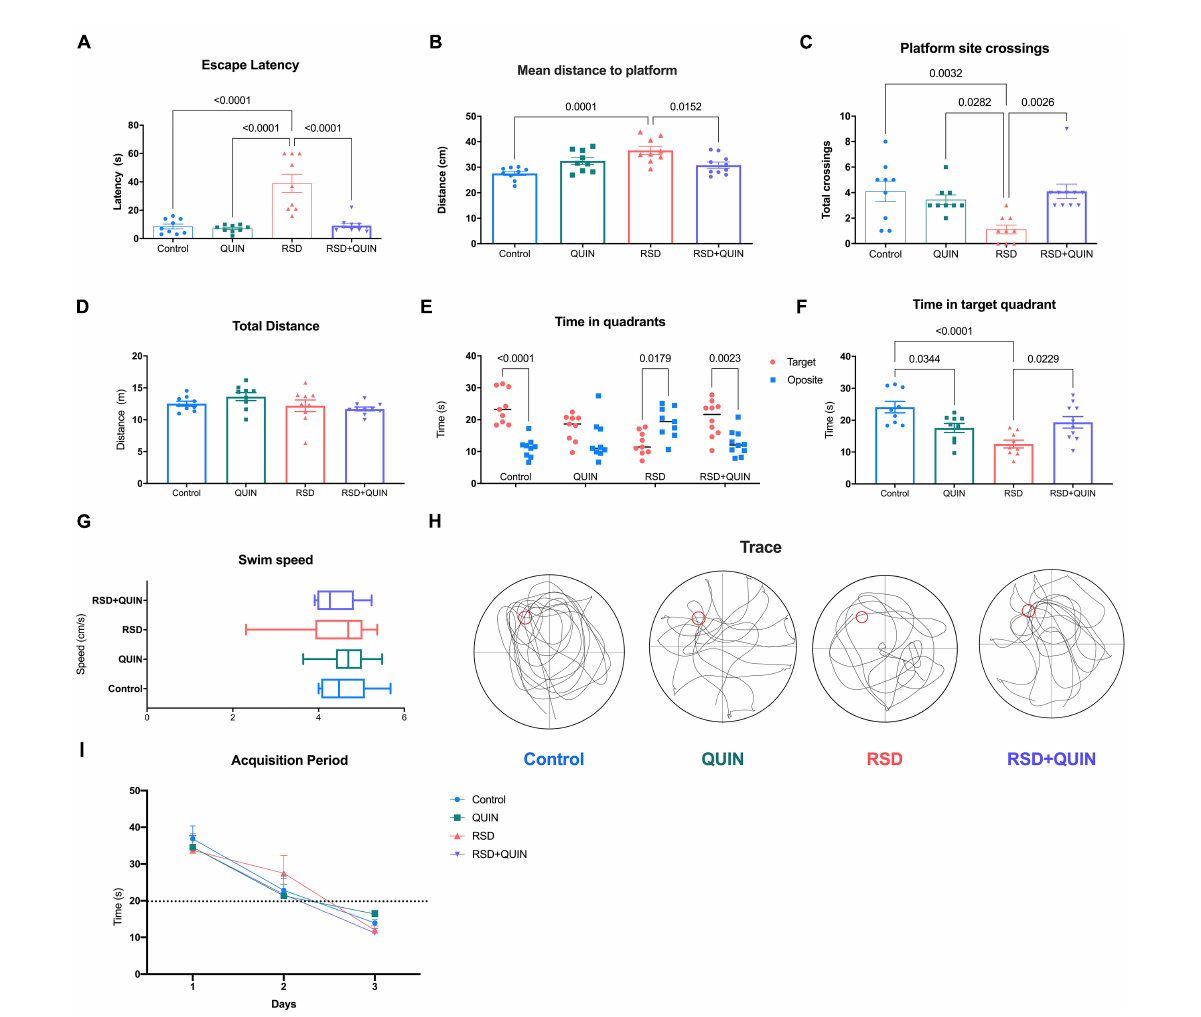
FIGURE4 Effect of Quinpirole (QUIN) and REM sleep deprivation (RSD) on spatial memory. The RSD was administered for 72 h starting after the last training session in the MWM. The evocation test analysis (A–H) consisted of 60 s of navigation assessed at the end of the RSD. The following evocation parameters are shown escape latency to the site of the platform (A) , average navigation distance to the platform (B) , the number of platform site crosses (C) , total distance navigated (D) , total time spent in target and opposite quadrants (E) , time spent in the target quadrant (F) , navigation speed (G) and typical navigation traces (H) . Repeated training sessions over 3 days resulted in shorter latencies and higher performance in platform localization (I) . Mice were administered with QUIN (2 mg/kg for 3 days) and subjected to RSD after acquisition. Data are presented as the mean ± SEM and were analyzed using one-way ANOVA followed by Tukey’s post-hoc test (A–D,F,G) and Student’s t -test (E) . Control n = 9, QUIN n = 9, RSD n = 9, RSD + QUIN n = 10. Statistically significant differences among the experimental groups are indicated.